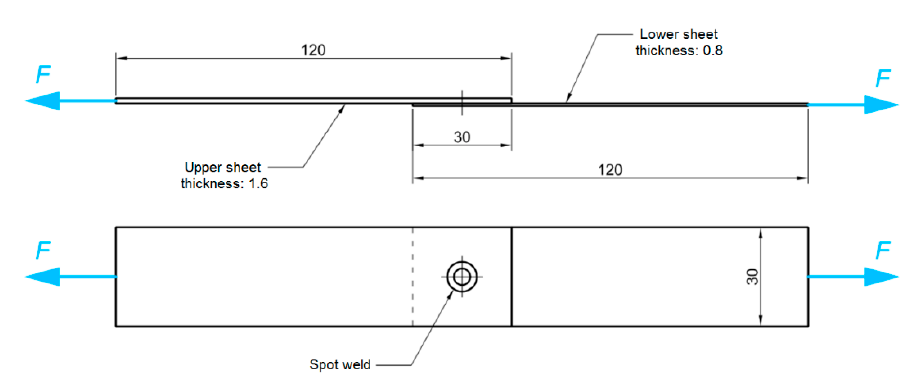
Figure 1. Dimensions (in mm) of the specimen for tensile/shear testing.